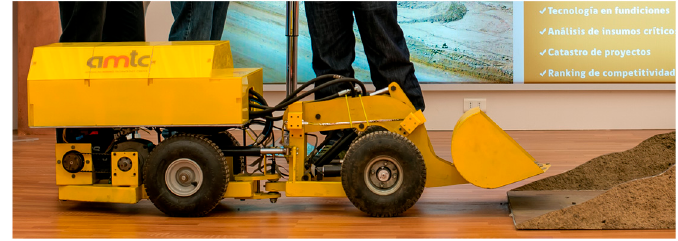
Figure 12. 1:5 scaled LHD built for testing and validation.